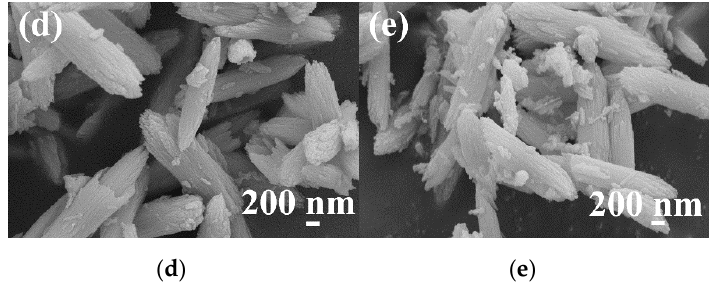
Figure 7. SEM images of samples synthesized at different hydrothermal times: ( a ) 6 h; ( b ) 12 h; ( c ) 18 h; ( d ) 24 h; ( e ) 48 h.